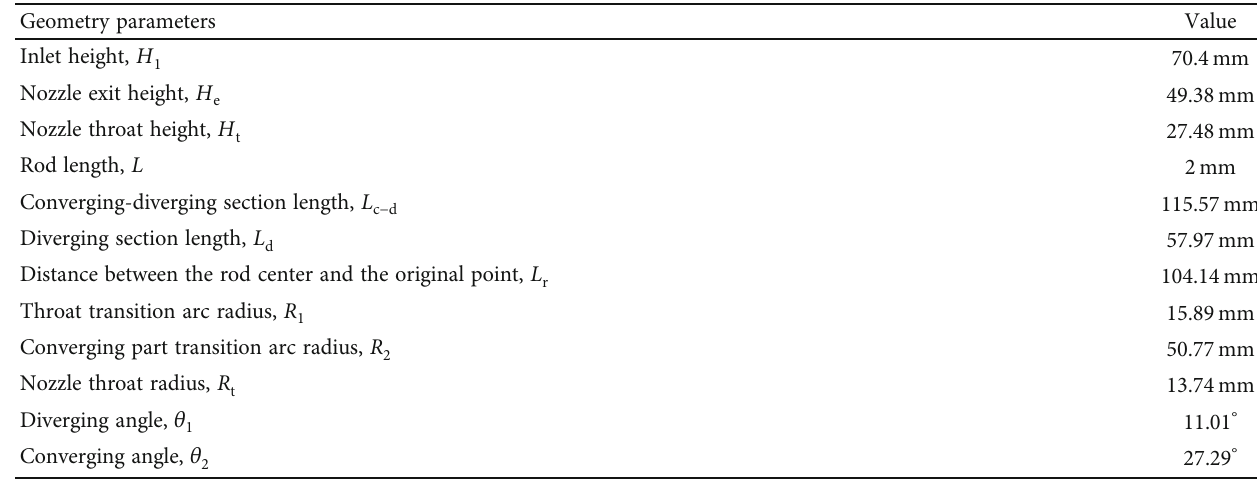
Figure 3: Geometry description of the CFD Table 1: Detailed geometry description.